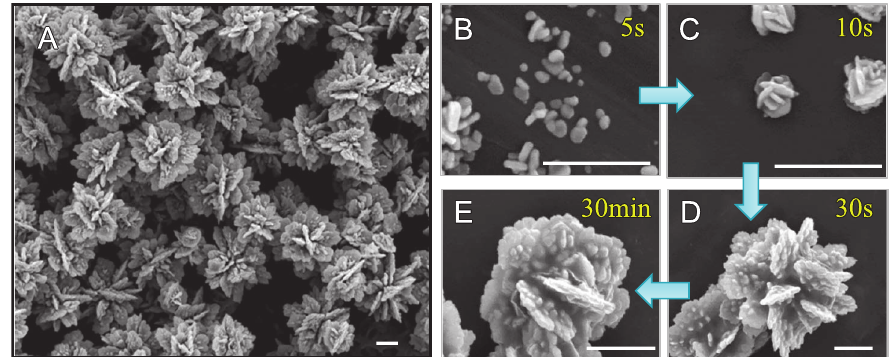
Fig. 5 SEM images of the silver products synthesized by the solution-based reduction approach in 10 mM gly- cine solution. A showing the low-magnification SEM image of silver flowers synthesized after 30 m in, indicating uniform and high-yield of products. B showing nanosized silver particles synthesized after 5 s reaction; C showing the silver aggregates composed of flakes synthesized after 10 s reaction; D and E showing silver flower synthesized in 30 s and 30 min, respectively. The scale bars represent 1